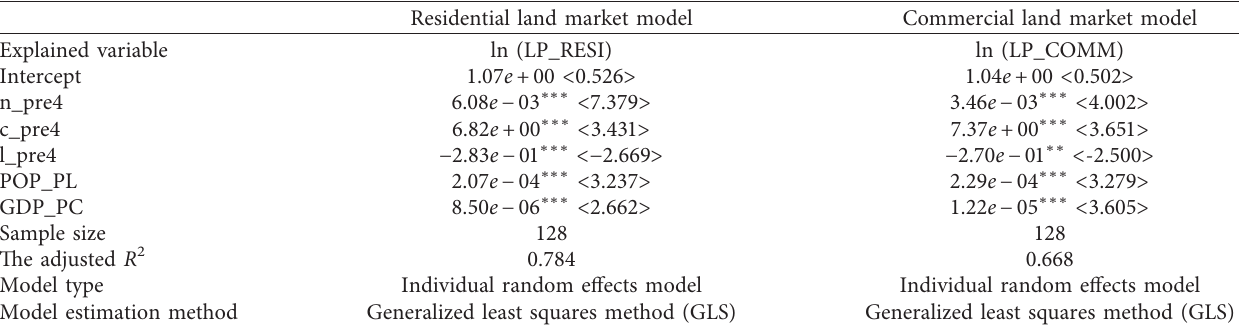
Table 8: The results of the regression model.